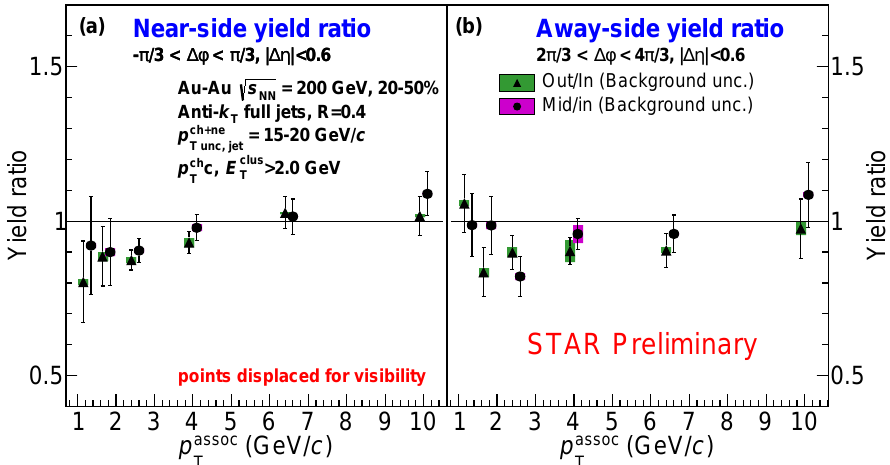
Figure 2. The ( a ) near-side and ( b ) away-side out/in and mid/in yield ratios for R = 0.4 full jets in √ s NN = 200 GeV for the 20–50% centrality class. The colored bands correspond Au–Au collisions at to the RPF background uncertainty which is non-trivially correlated point-to-point [10]. There is an additional 6% global scale